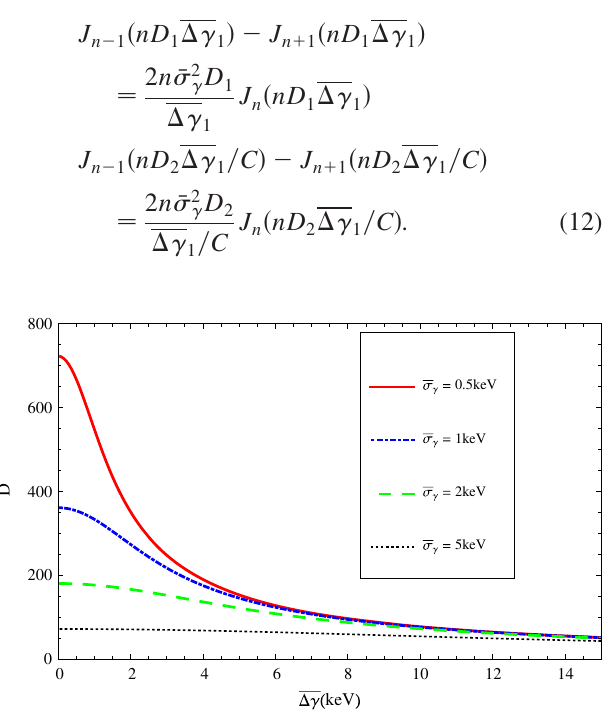
FIG. 2. Optimized DS strength as a function of energy modu- lation amplitude for various values of local energy spread. The (cid:3) FIG. 1. Bunching factor squared as a function of DS strength (cid:2) is changed from 0.5 to 5 keVand the optimized value of for different conditions. Solid line: (cid:3) (cid:2) ¼ 1 keV , (cid:1) (cid:2) ¼ 10 keV ; obtained by numerically solving the first root from Eq. (10). dot dashed line: (cid:3) (cid:2) ¼ 2 keV , (cid:1) (cid:2) ¼ 10 keV ; dashed line: (cid:3) (cid:2) ¼ Solid line: (cid:3) (cid:2) ¼ 0 : 5 keV ; dot-dashed line: (cid:3) (cid:2) ¼ 1 keV ; dashed 1 keV , (cid:1) (cid:2) ¼ 3 keV ; dotted line: (cid:3) ¼ 2 keV , (cid:1) (cid:2) ¼ 3 keV . line: (cid:3) (cid:2) ¼ 2 keV ; dotted line: (cid:3) (cid:2) ¼ 5 keV (cid:2)